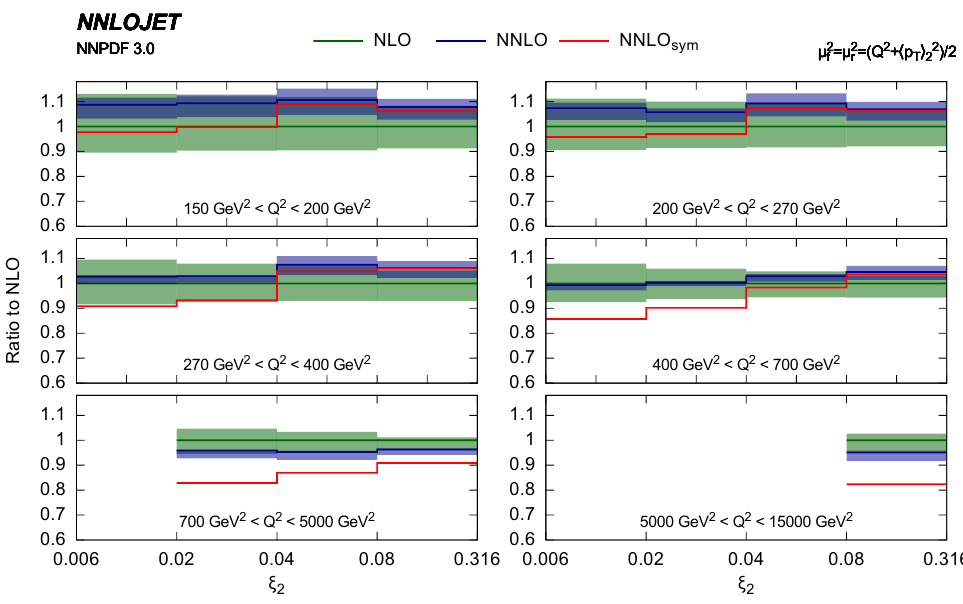
Figure 16 . Inclusive di-jet production cross section as a function of (cid:24) 2 in bins of Q 2 with asymmetric cuts on the two jets. The red line indicates the NNLO prediction with symmetric cuts of (cid:12)gure 15.